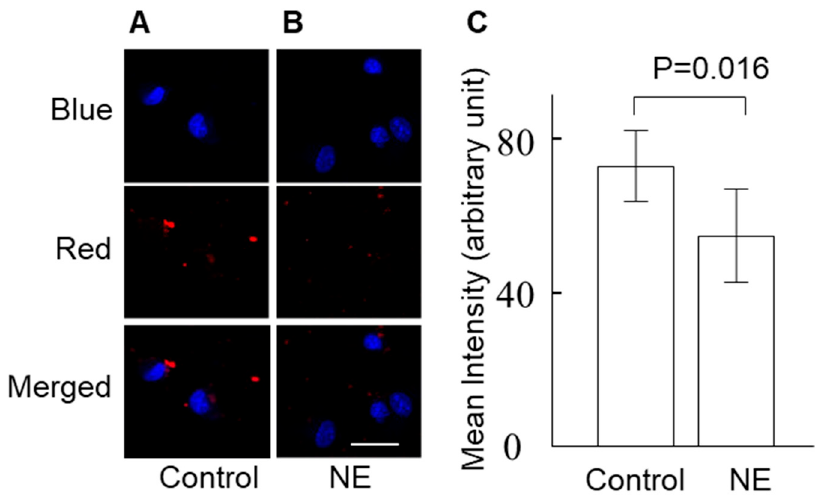
Figure 1. Norepinephrine (NE) increased oxidised low-density lipoprotein (LDL) uptake in vascular smooth muscle cells (VSMCs). VSMCs were incubated with NE (0.1 µM) or phosphate-buffered saline (PBS, control) for 30 min, and then the cells were treated with Dil-labelled oxidised LDL (25 µg/L) for 4 h. After staining the nucleus with Hoechst, the intracellular red fluorescence (Dil-labelled oxidised LDL) and blue fluorescence (nucleus) were imaged via a confocal microscope. ( A , B ) Representative images of oxidised LDL (red channel), nucleus (blue channel) and merged channels of cells in PBS-incubated ( A ) and NE-incubated cells ( B ). Scale bar = 40 µm. ( C) The mean intensity of intracellular Dil-labelled oxidised LDL fluorescence. The mean intensity of Dil-labelled oxidised LDL fluorescence (red) in the cells was analysed using ImageJ. The difference between the groups was analysed using the Mann–Whitney U test. Data represent mean ± SD; N = 8.